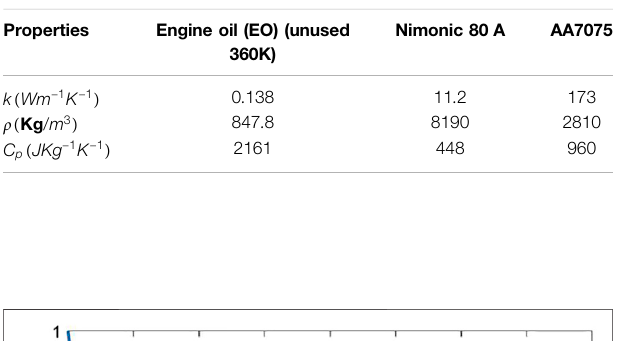
TABLE 1 | The material features of the base fl uid and nanoparticles (Reddy et al., 2020; Tlili et al., 2020; Raju et al., 2021).